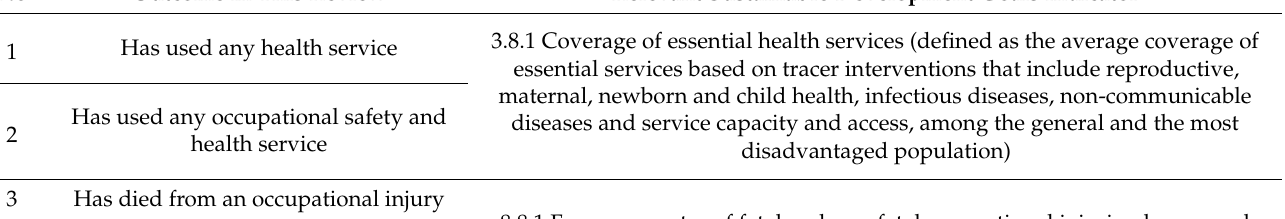
Table 1. Prioritized outcomes and related sustainable development goals indicators. Relevant Sustainable Development Goals Indicator 3.8.1 Coverage of essential health services (defined as the average coverage